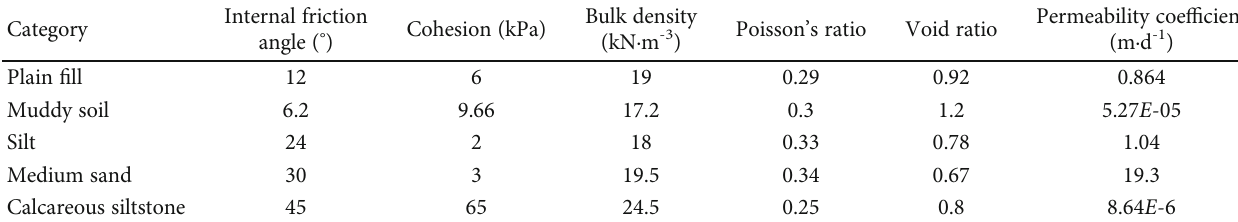
Table 1: The properties of rock-soil mass.